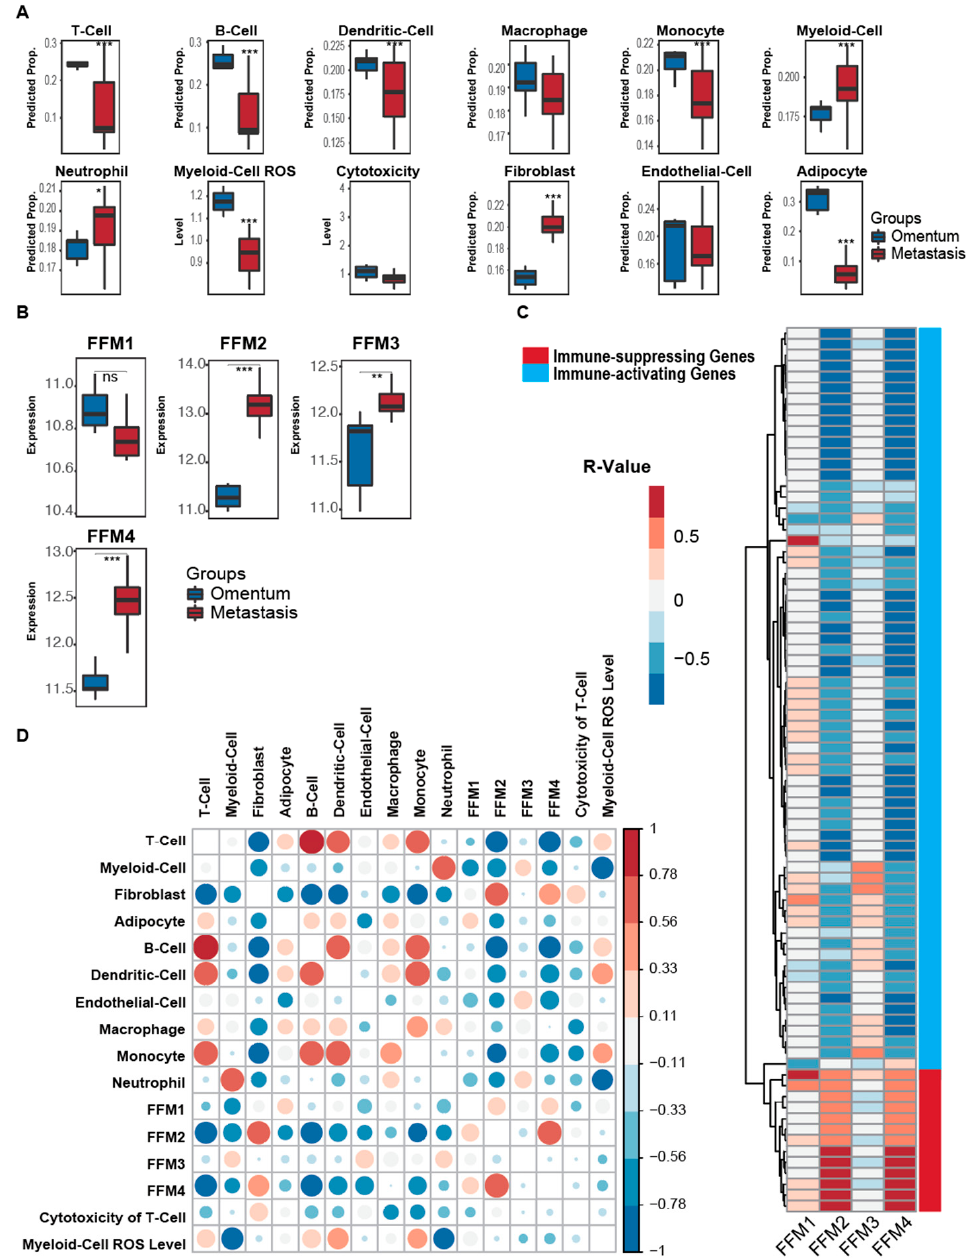
Figure 3. Comparison of the stromal cells of omental metastasis and normal omentum in an ovarian cancer mouse model. ( A ) Plots depicting predicted proportions of stromal cells in the normal omentum compared to omental metastases. ( B ) Box plots showing the expression levels of the 4 fibroblast functional modules (FFM1–4) in normal omental tissues compared to omental metastases. ( C ) Heatmap showing the Spearman correlation of 4 fibroblast functional modules and immune-associated markers in metastatic tissues. Red or blue boxes indicate positive or negative correlation between the immune-associated marker and the corresponding fibroblast functional module (FFM1–4), respectively. Grey boxes indicate no correlation. Red and blue bars on the right indicate the immune-suppressing and immune-activating markers, respectively. FFM, fibroblast functional module. ( D ) A correlation analysis between the stromal cell types in the metastasis. The color scale for R -values are provided on the right. The sizes of the dots are also proportional to the magnitude of the R -value. *** p < 0.001, ** p < 0.01, * p < 0.05.